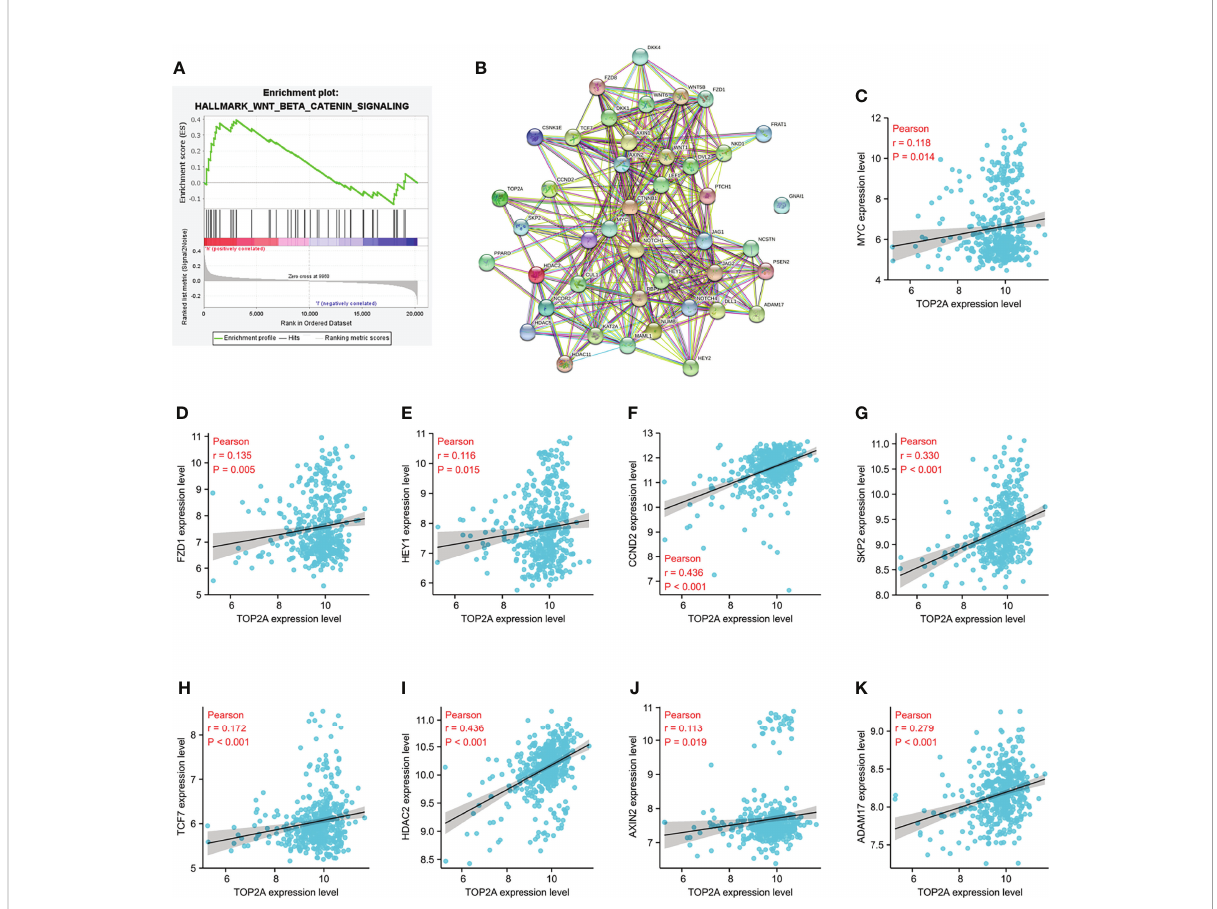
FIGURE 9 Enrichment pathways analysis of TOP2A based on GSE85217 dataset. (A) HALLMARK_WNT_BETA_CATENIN signaling pathways enriched across DEGs by GSEA analysis. (B) PPI network of the genes of Wnt/ b -catenin signaling pathway in GSEA analysis constructed by STRING analysis. (C K) Co-expression analysis of TOP2A with the core genes of Wnt/ b -catenin signaling